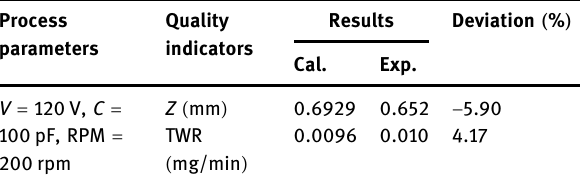
Table 5: Multi - objective optimization results